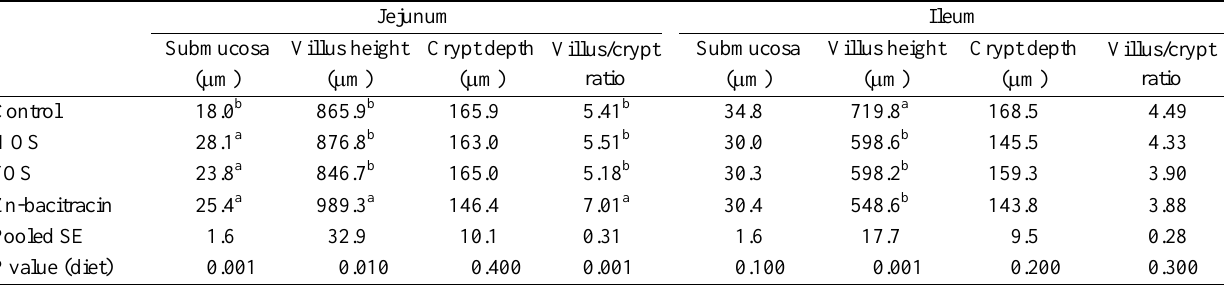
Table 5. Effects of oligosaccharides and antibiotic supplementation on histological development of jejunum ileum at 21 d of age (n =